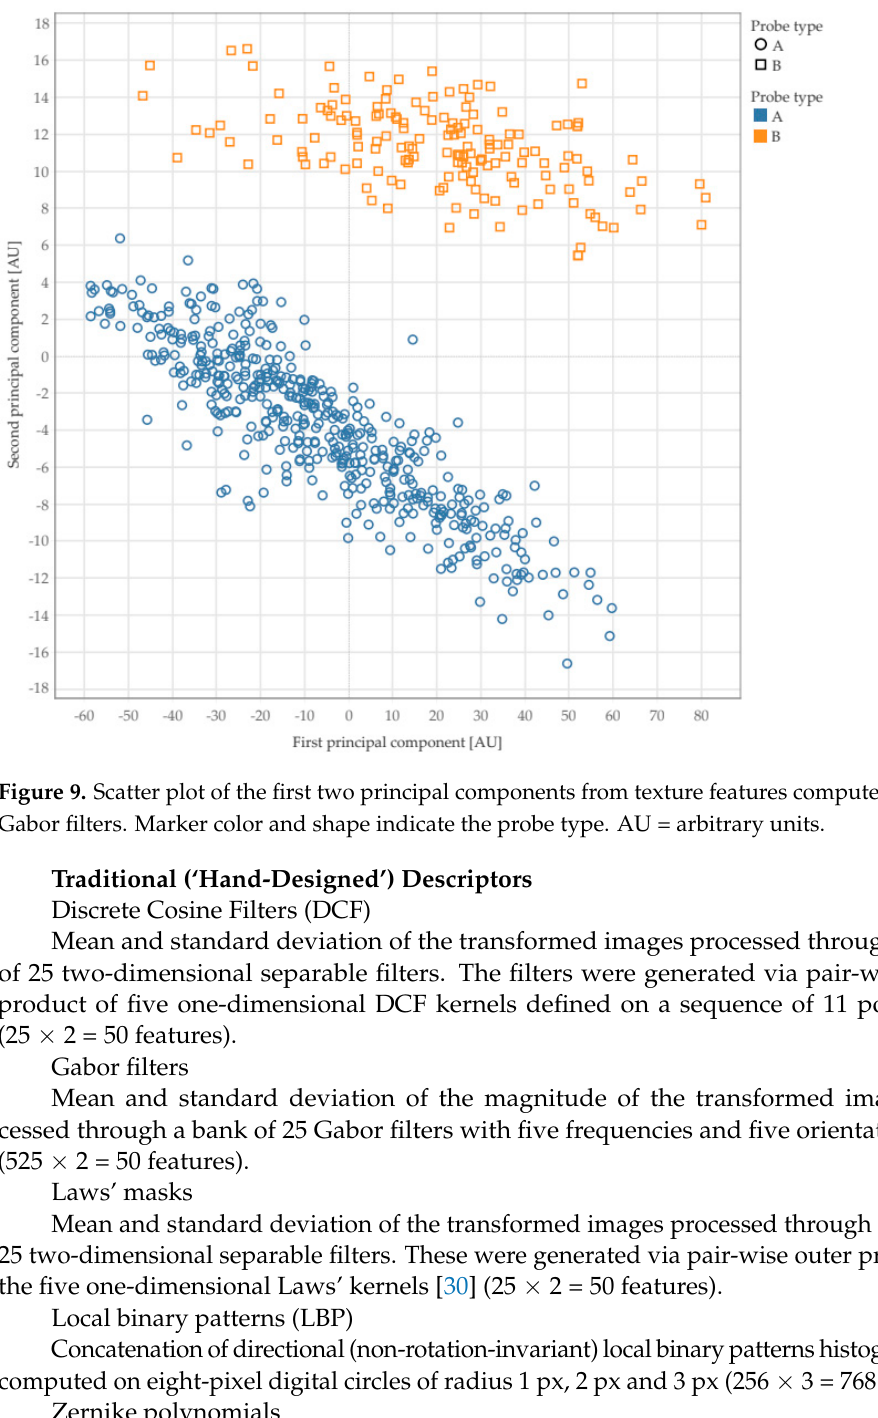
Figure 8. Scatter plot of the first two principal components from texture features computed through Gabor filters. Marker color shows details about the body part where the scan was taken; marker size and shape show, respectively, the age and gender of the subject. AU = arbitrary units.